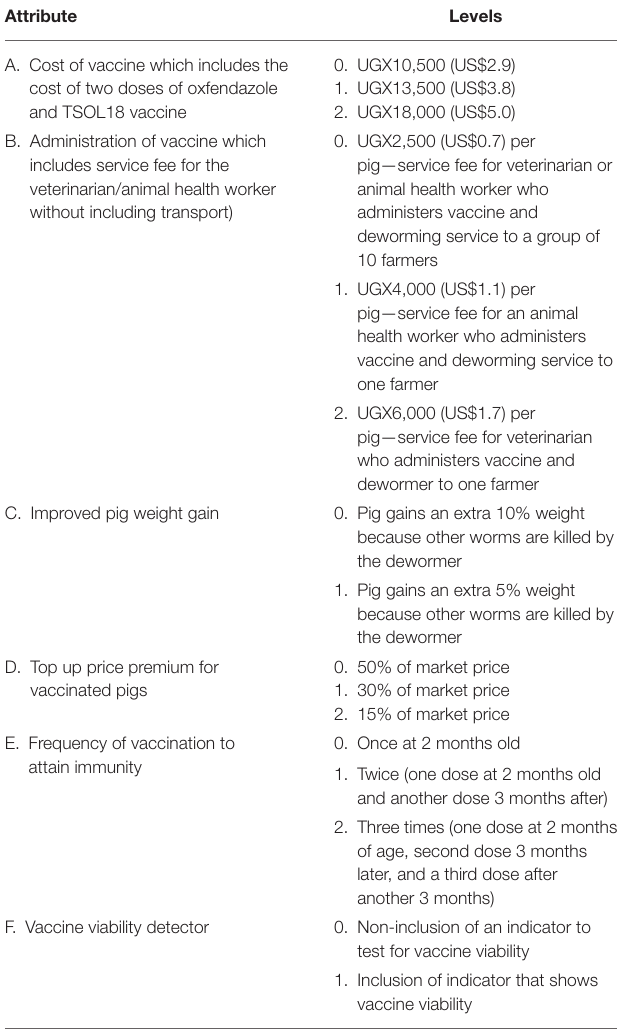
TABLE 1 | TSOL18 vaccine and oxfendazole attributes. Attribute